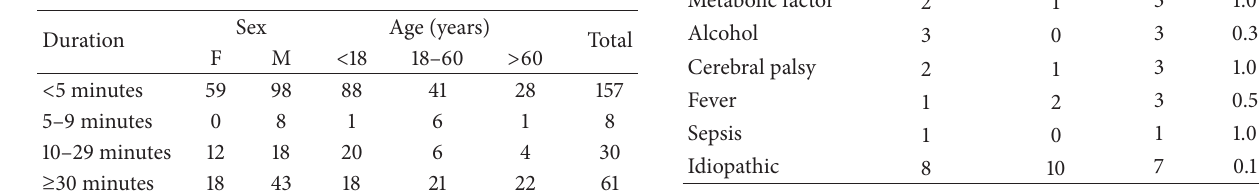
Table 3: Duration of all seizure episodes.